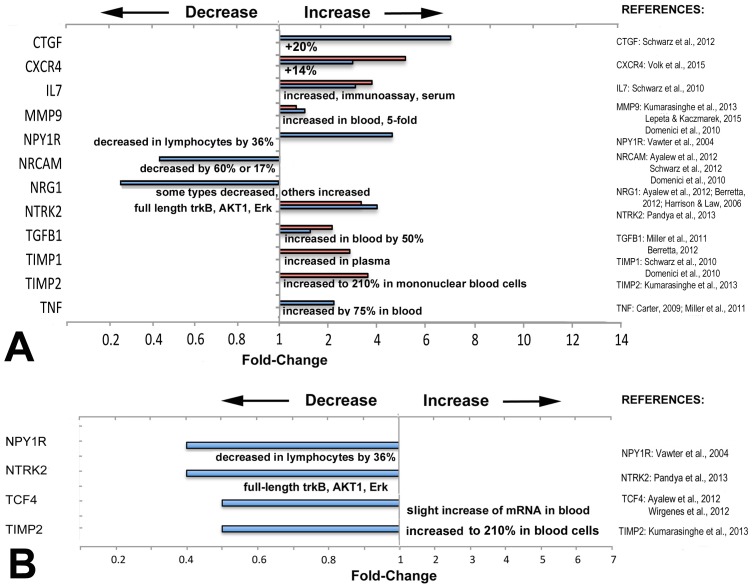
Directionality of altered expression of schizophrenia-related genes in extraocular muscles.(A) Directionality of altered expression of schizophrenia-related genes when medial rectus muscles have become dysfunctional, compared with tissues from schizophrenia patients (from the literature cited in Tables 2–6, and Domenici et al., 2010; Harrison & Law, 2006; Lepeta & Kaczmarek, 2015). Blue bars indicate data from PCR arrays, red bars indicate data from microarrays (Altick et al., 2012). References on the right contain the information about directionalities of changes of gene or protein expression in tissues from patients with schizophrenia. (B) Extent of apparent absolute deficits in expression of schizophrenia-related genes in medial rectus muscles from patients with exotropia (blue bars) as compared with the directionality of gene expression in tissues from schizophrenia patients (narrative, from the literature). Gene expression changes for medial rectus muscles compared with lateral rectus muscles.